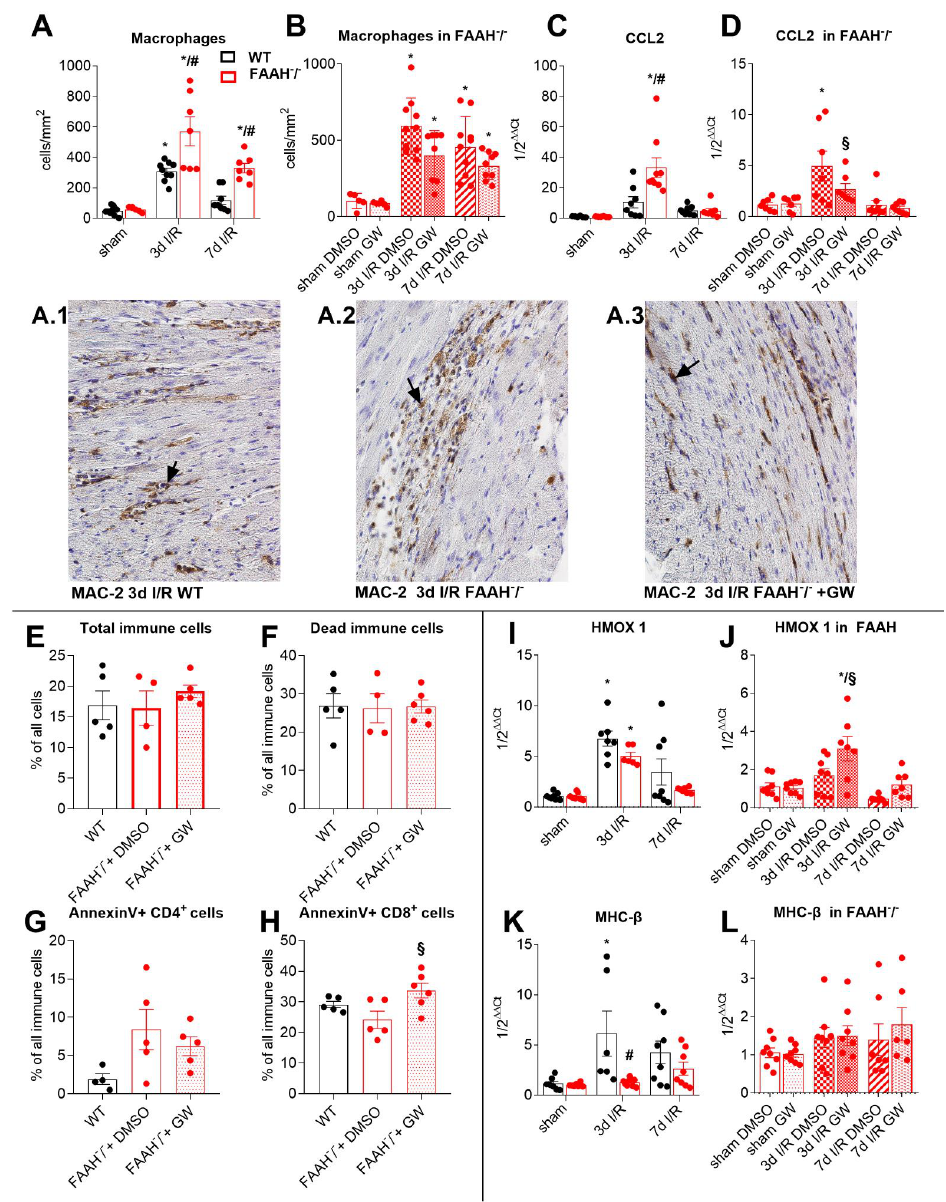
Figure 3. Fatty acid amide hydrolase deficiency modulates inflammation and adaptation. ( A ) In- creased macrophage accumulation in the FAAH − / − group compared to WT was ( B ) restored with GW6471 treatment (representative pictures in ( A.1 – A.3 ); macrophages accumulation is indicated with arrows). ( C ) Significantly increased CCL2 expression was observed in FAAH − / − group, but ( D ) de- creased after GW6471. ( E ) Amount of total immune cells and ( F ) dead immune cells was not changed. ( G ) Apoptosis of CD4 + cells was increased in FAAH –/ − group, and slightly decreased after GW6471 application. ( H ) Contrarily, apoptosis of CD8 + cells was reduced in FAAH − / − group, but increased again after GW6471 treatment. ( I ) Levels of HMOX 1 were significantly reduced in FAAH − / − group ( J ) but increased after GW6471 application. ( K ) Energetically efficient myosin heavy-chain isoform MHC- β was suppressed in FAAH − / − mice, ( L ) but reversed after GW6471 treatment. RT-qPCR using Taqman ® , expression is related to sham and GAPDH using comparative ∆∆ Ct method. Magnification in ( A.1 – A.3 ): 400 × . MHC- β , beta-myosin heavy chain; CCL2, chemokine ligand-2; DMSO, Dimethyl sulfoxide; FAAH, fatty acid amide hydrolase; HMOX 1, heme oxygenase 1 gene; IL-10, Interleukin-10; WT, wild-type. *, p < 0.05 vs. respective sham; #, p < 0.05 FAAH − / − vs. WT at respective time point; §, p < 0.05 FAAH − / − +GW vs. FAAH − / − +DMSO at the respective time